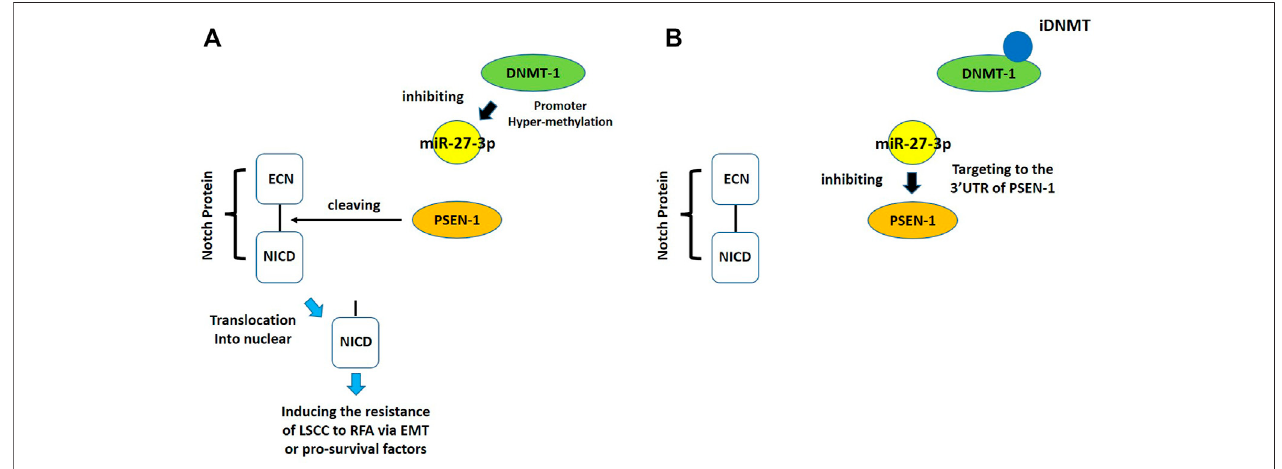
FIGURE 9 | Proposed model of the present work. (A) In LSCC cells, DNMT-1 may induce cleavage and methylation of the miR-27-3p promoter, thereby inhibiting expression of miR-27-3p. Low miR-27-3p expression leads to upregulated PSEN-1 expression, which activates the Notch pathway by cleaving the Notch protein. (B) Treating LSCC cells with iDNMT inhibits DNMT-1 activity, downregulates methylation of the miR-27-3p promoter region, upregulates miR-27-3p expression, downregulates PSEN-1 expression, and ultimately inhibits Notch pathway activity.